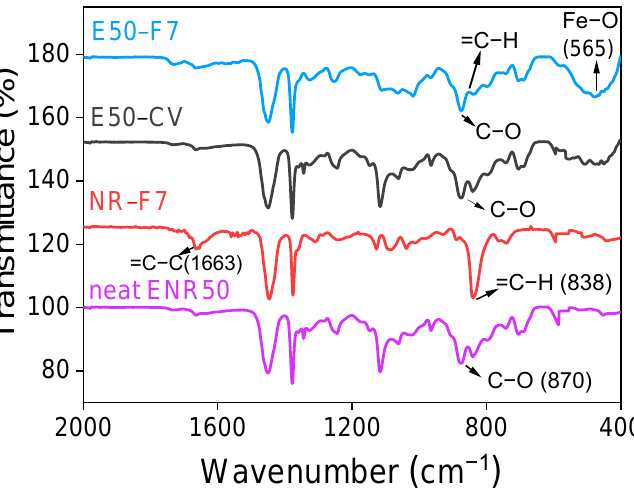
Figure 5. ATR-FTIR spectrum of the neat ENR-50, ENR-50 compounded with 7 mmol of FeCl 3 (E50-F7) and the conventional sulfur vulcanization (E50-CV) as well as the unmodified NR (ADS) compounded with 7 mmol FeCl 3 (NR-F7).